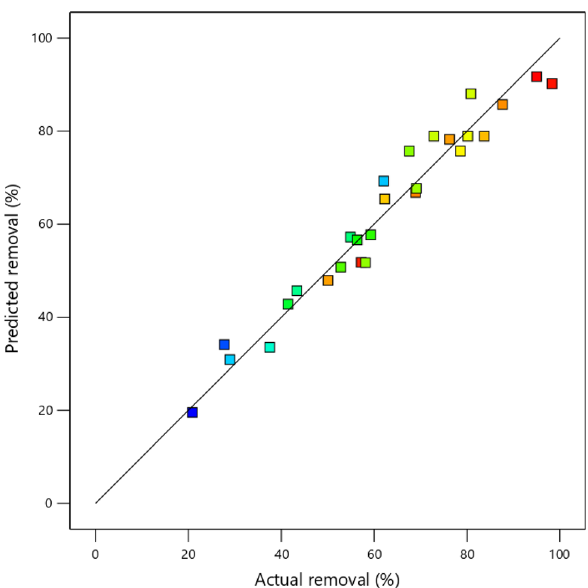
Table 5 ANOVA for quadratic model of R141 removal using γ -Al